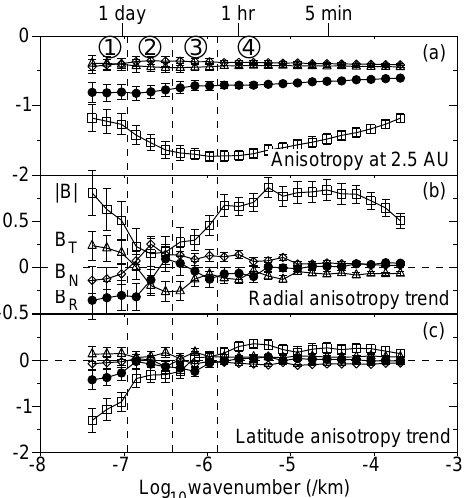
Figure 59: (a) Scale dependence of power anisotropy at 2.5 AU plotted as the log (solid circles), 𝐵 𝑇 (triangles), 𝐵 𝑁 (diamonds), and | B | (squares) to the trace of the spectral matrix; (b) the radial, and (c) latitudinal behavior of the same values, respectively. Image reproduced by permission from Horbury and Balogh (2001), copyright by